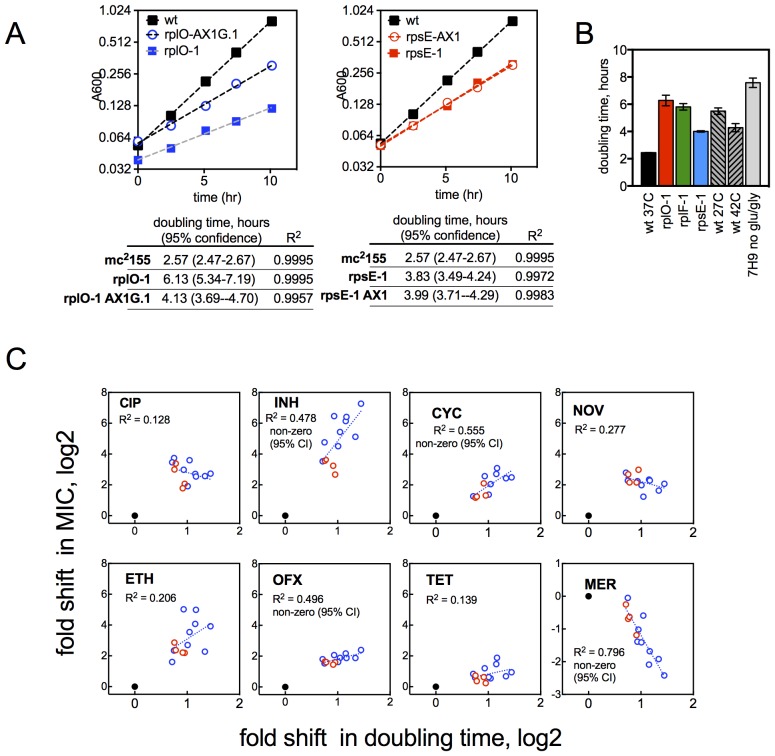
Growth rates of mutants and their relationship with resistance levels.(A) Growth rates of allelic exchange mutants. All strains were grown in 30 ml volumes in foil-sealed Erlenmeyer flasks at 37°C with shaking. At regular intervals, cultures were sampled and density measured based on absorbance at 600 nM. Doubling times were calculated by fitting a line to log2 transformed absorbance values using GraphPad Prism. (B) Doubling times under conditions tested in Figure 3C, with mutants shown for comparison. Mean ±95% CI. (C) Changes in MIC plotted against the doubling time of each mutant for CIP and INH. Dashed line = linear regreasion of data; lfrR mutants, where known to be due to efflux, and the parental strain were excluded from the regression analysis. Doubling time (x-axis) was measured as described in Methods and y-axis is the fold shift in MIC (measured as IC50, determined as described in Methods). CIP = ciprofloxacin, INH = isoniazid, OFX = ofloxacin, SM = streptomycin, NOV= novobiocin, CYC = cycloserine, ETH = ethionamide, MER = meropenem, TET = tetracycline, EMB = ethambutol. Dots represent individual mutants. Black dot is parent, rps/rpl mutants are blue and rrlB mutants are red. Panels note whether the 95% confidence interval of the slope of the fitted line does not span zero, supporting a correlation.